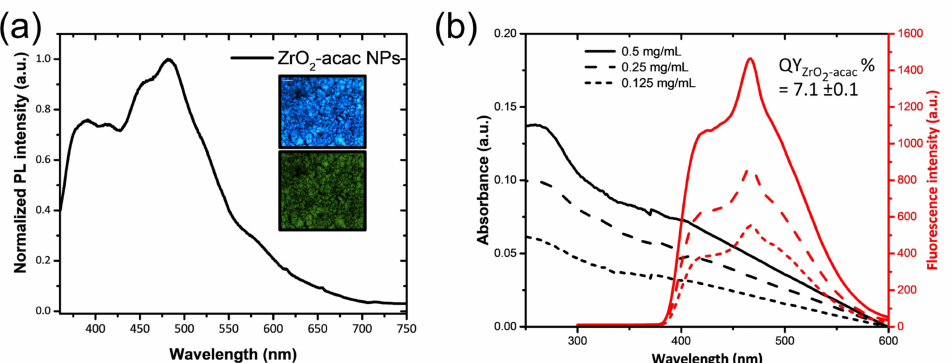
Figure 2. ( a ) Photoluminescence spectrum of ZrO 2 -acac NPs at the excitation wavelength of 325 nm; in the inset, fluorescence microscopy images of ZrO 2 -acac NPs at the excitation wavelengths of 365 nm (on the top) and 470 nm (on the bottom). ( b ) Absorbance and relative photoluminescence of ZrO 2 -acac NPs at different